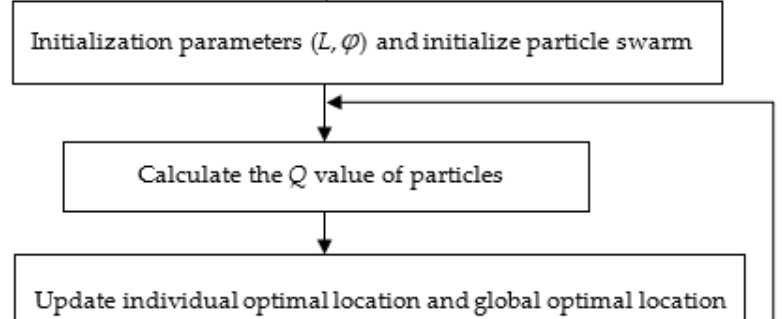
Figure 5. Parameter influence analysis. ( a ) L = 1900, ϕ = 20; ( b ) L = 1900, ϕ = 200; ( c ) L = 3000, ϕ = 100; ( d ) L = 2500, ϕ = 100.